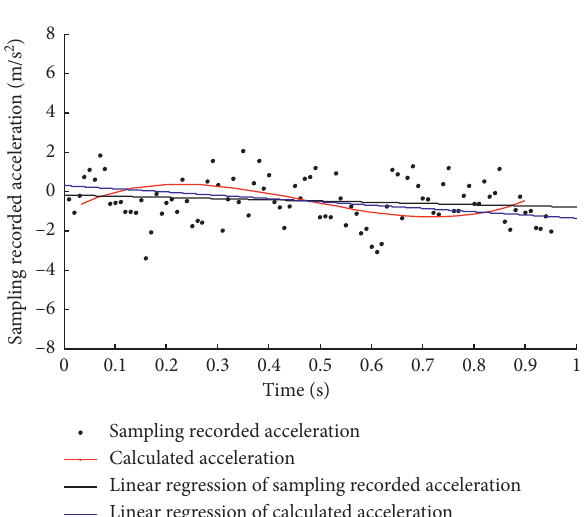
Figure 9: Compared analysis of a and a